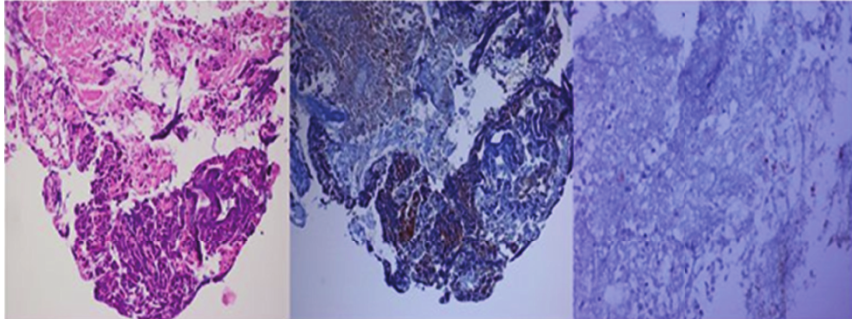
Figure 3: Malignant tumor consisting of small, carrot-shaped blue cells invading the surrounding soft tissue (H&E, × 100). Pan-cytokeratin immunopositivity in most of the tumor cells (DAB, × 100). Synaptophysin immunopositivity in a few necrotic tumor cells (DAB, × 200).